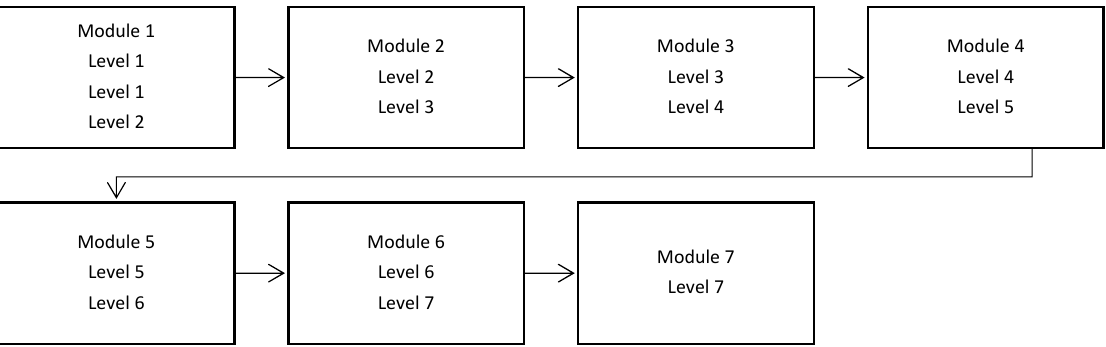
Figure 1. RET hink game modules and the corresponding levels.